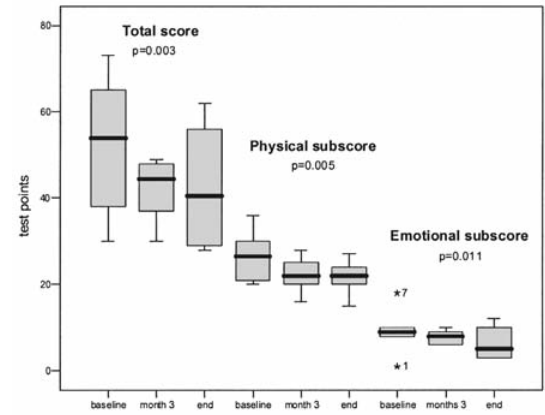
Quality of life meas- ured by the Min- nesota living with heart failure ques- tionnaire at baseline, three and six month of Bosentan treat-